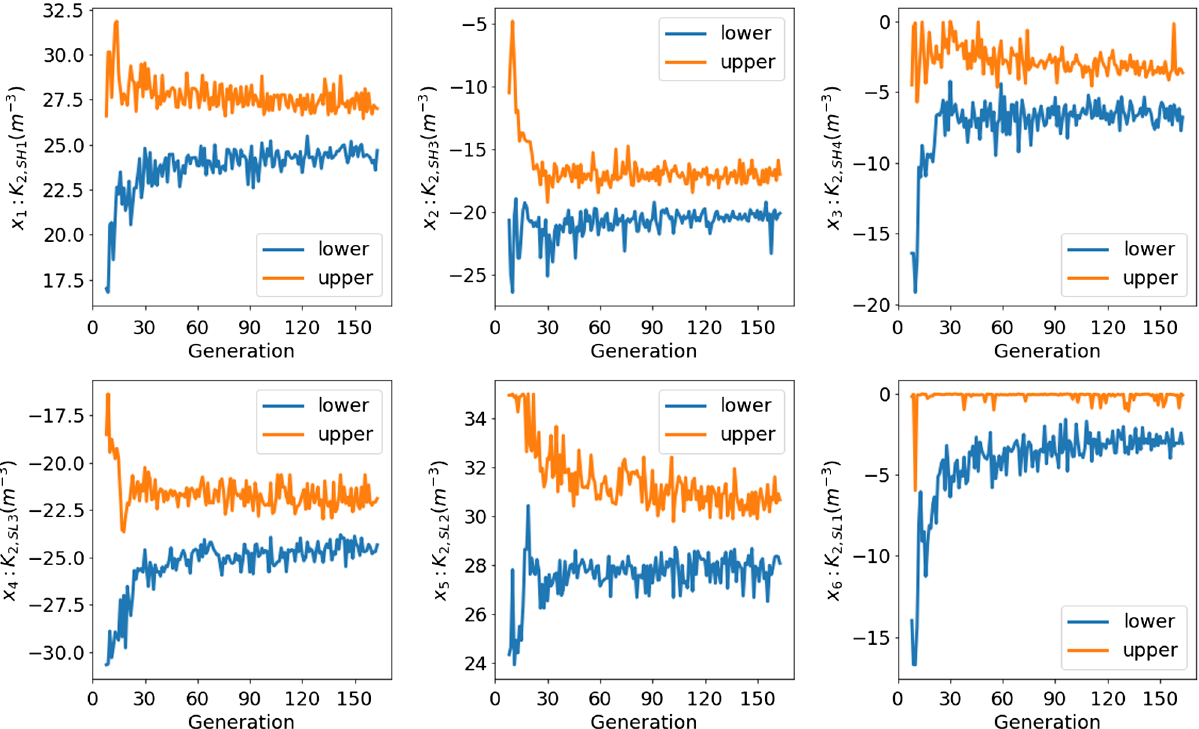
FIG. 5. Variation of the ranges for generating new elite population in six-dimensional search space (sextupole ’ s K 2 ) along the evolution. The elite ranges fluctuate, but gradually converge toward much narrower